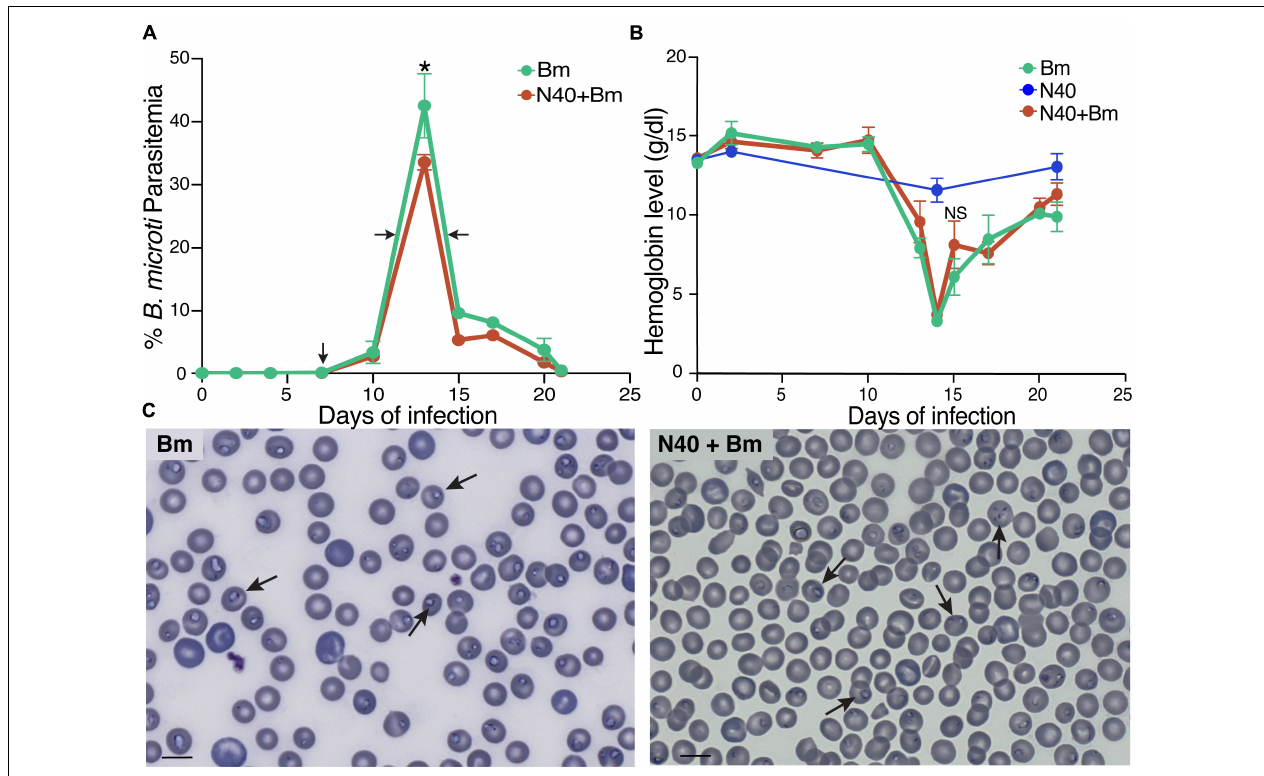
FIGURE 1 | Effect of B. burgdorferi strain (N40) co-infection on B. microti ( Bm ) growth. (A) Percent of RBCs infected with B. microti in C3H mice infected either with B. microti alone, or with B. microti and N40, was determined over 21 days p.i. Each data point represents average parasitemia ± s.d. ( n = 5). Both groups of mice exhibited peak parasitemia at 13th day p.i. with significantly high peak parasitemia in Bm- infected mice ( ∗ p < 0.05, df = 8, F = 1.72). (B) Hemoglobin levels were measured for 21 days p.i. N40-infected mice were used as controls. (C) Examination of blood smears showed lower erythrocytes density and higher parasitemia in Bm- infected mice (left) than co-infected mice (right). Bar represents 10 µ m and arrows indicate parasitized